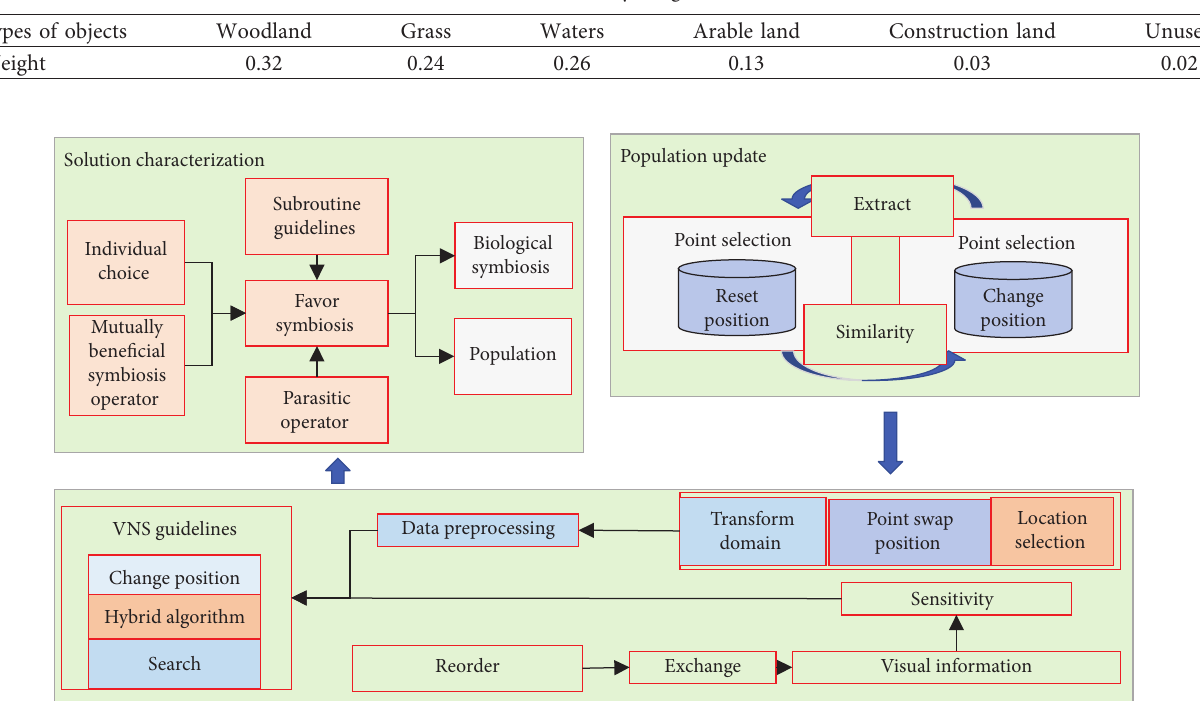
Figure 2: Block diagram of image search reordering based on the hybrid feature graph model.